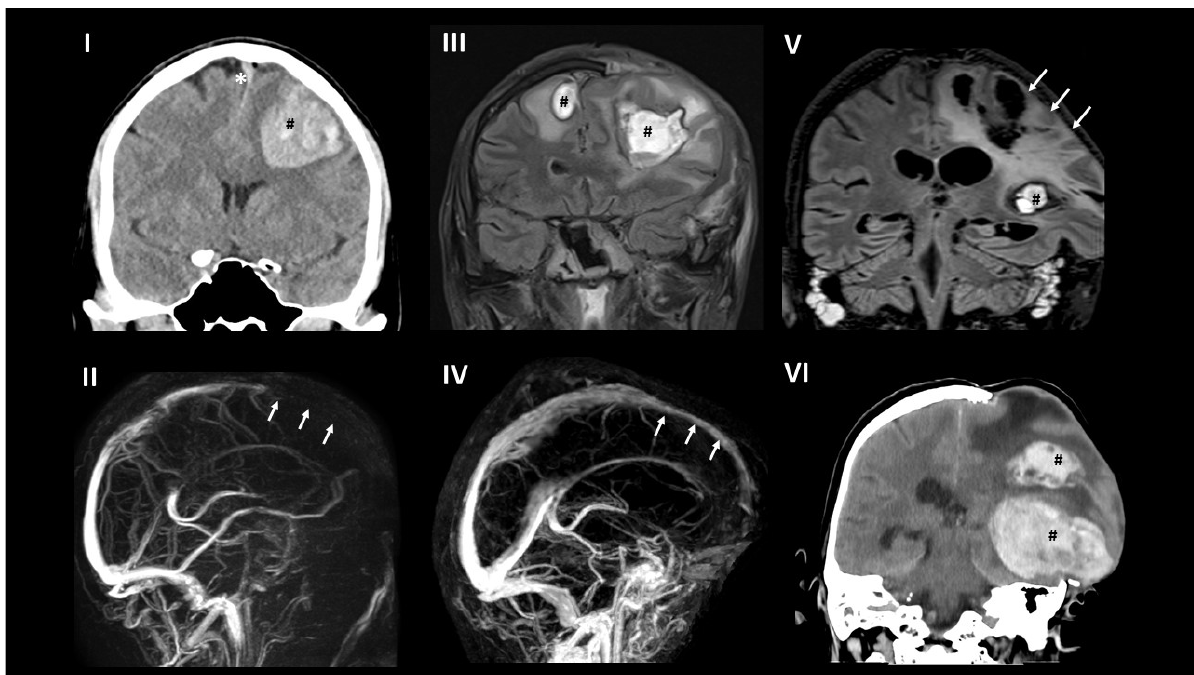
Figure 2. Brain imaging. ( I ) (day 1): In plain CT superior sagittal sinus thrombosis (*) and left frontal hematoma (#) was present. ( II ) (day 1): contrast-enhanced MRI revealed extensive superior sagittal sinus thrombosis (arrows). ( III ) (day 21): MRI (fluid-attenuated inversion recovery; FLAIR) three weeks after decompression hemicraniectomy showed the known bifrontal hemorrhagic infarction (#). ( IV ) (day 87): contrast-enhanced MRI demonstrated recanalization of the superior sagittal sinus (arrows). ( V ) (day 87): MRI FLAIR revealed a new small ICH in the temporal lobe (#) and the chronic lesions (arrows) with significant prolapse of the left cerebral hemisphere. ( VI ) (day 103): plain CT demonstrated fatal new left parietal and temporal ICH (#).